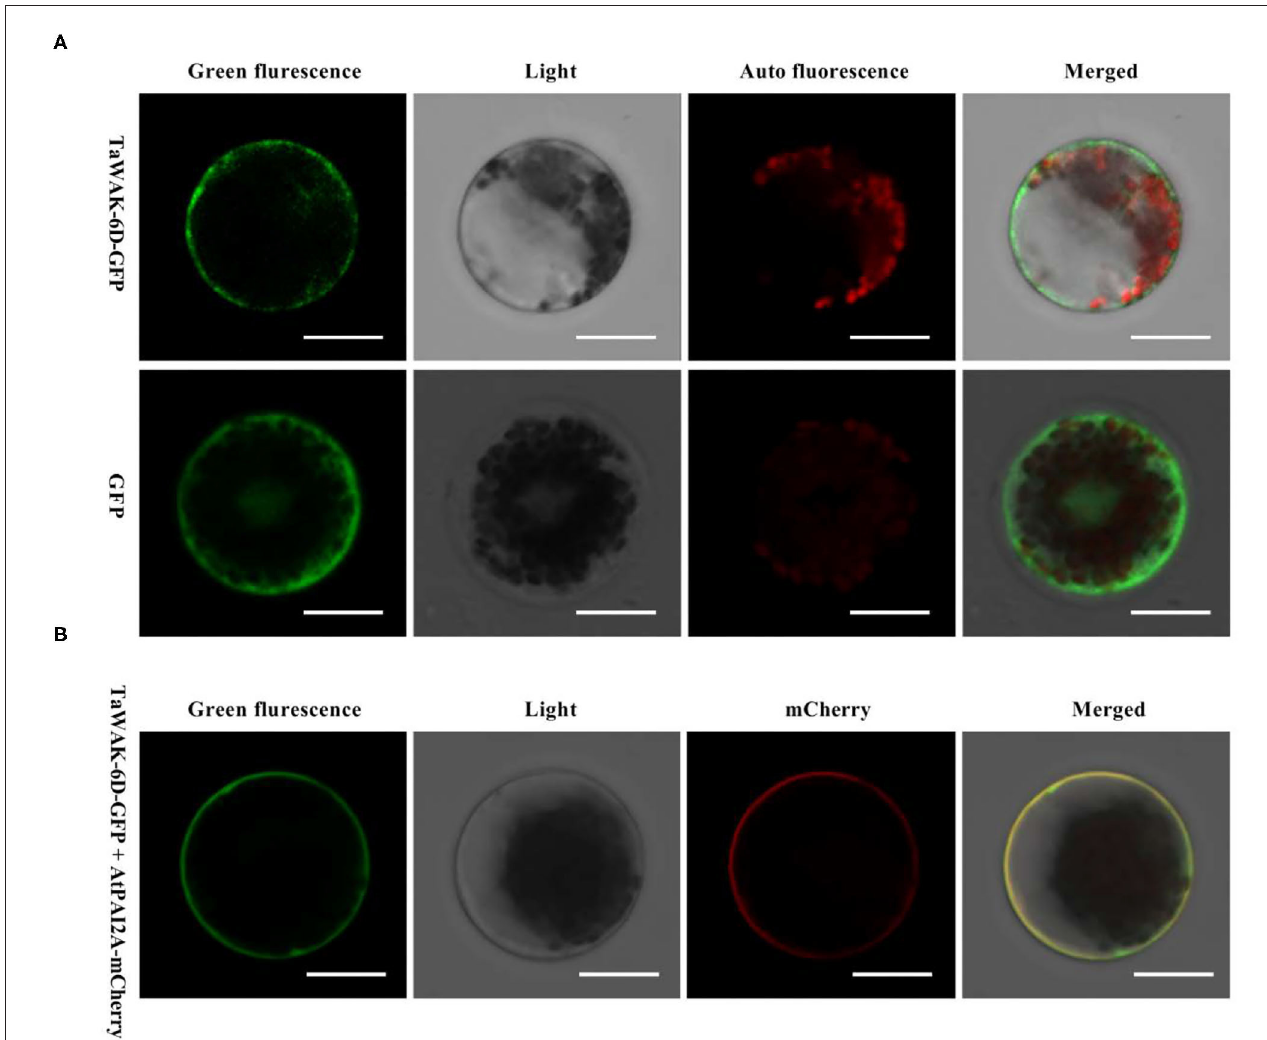
FIGURE 4 | Subcellular localization of TaWAK-6D protein in wheat protoplasts. (A) The control 35S: GFP and fused 35S: TaWAK-6D–GFP construct plasmids were transiently expressed in mesophyll protoplasts cells. The red color was auto-fluorescence from the wheat chloroplast. (B) The fused 35S: TaWAK-6D–GFP and the plasma marker (PM) 35S: AtPAI2A–mCherry vector plasmids were co-transiently expressed in mesophyll protoplasts cells. Scale bars = 20 µ